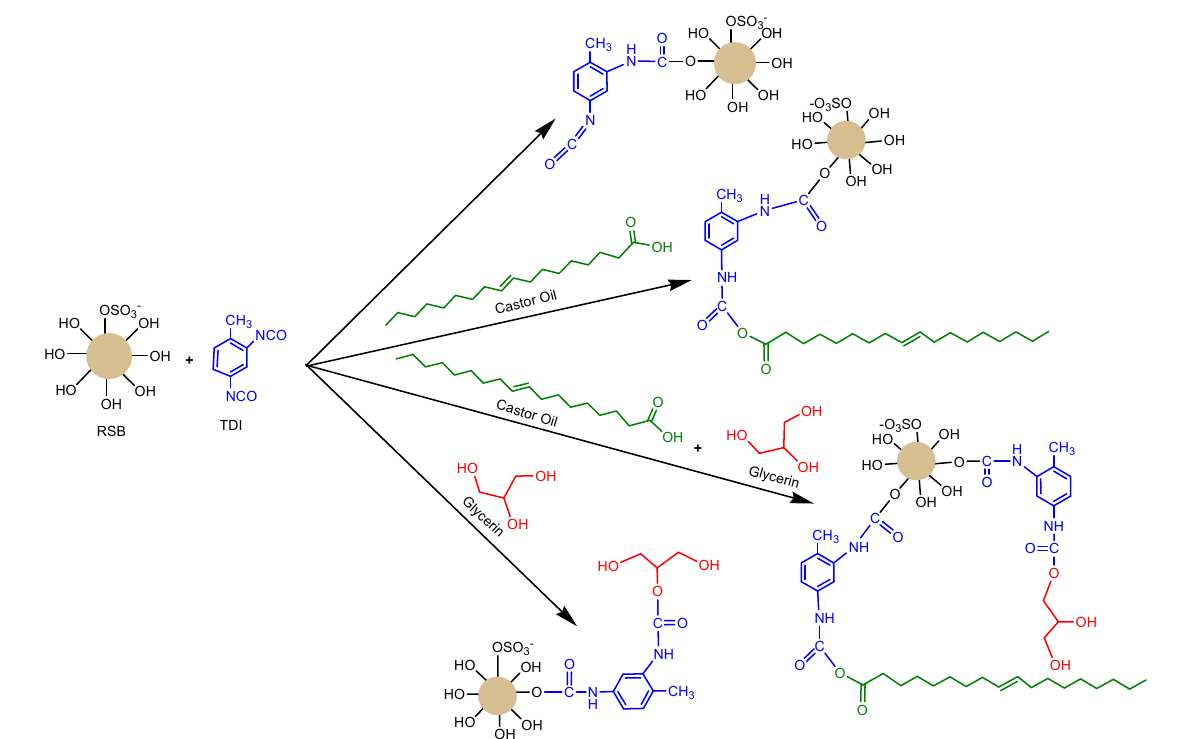
Figure 3. Reaction of PUM-RSB synthesis [1,36,39] .